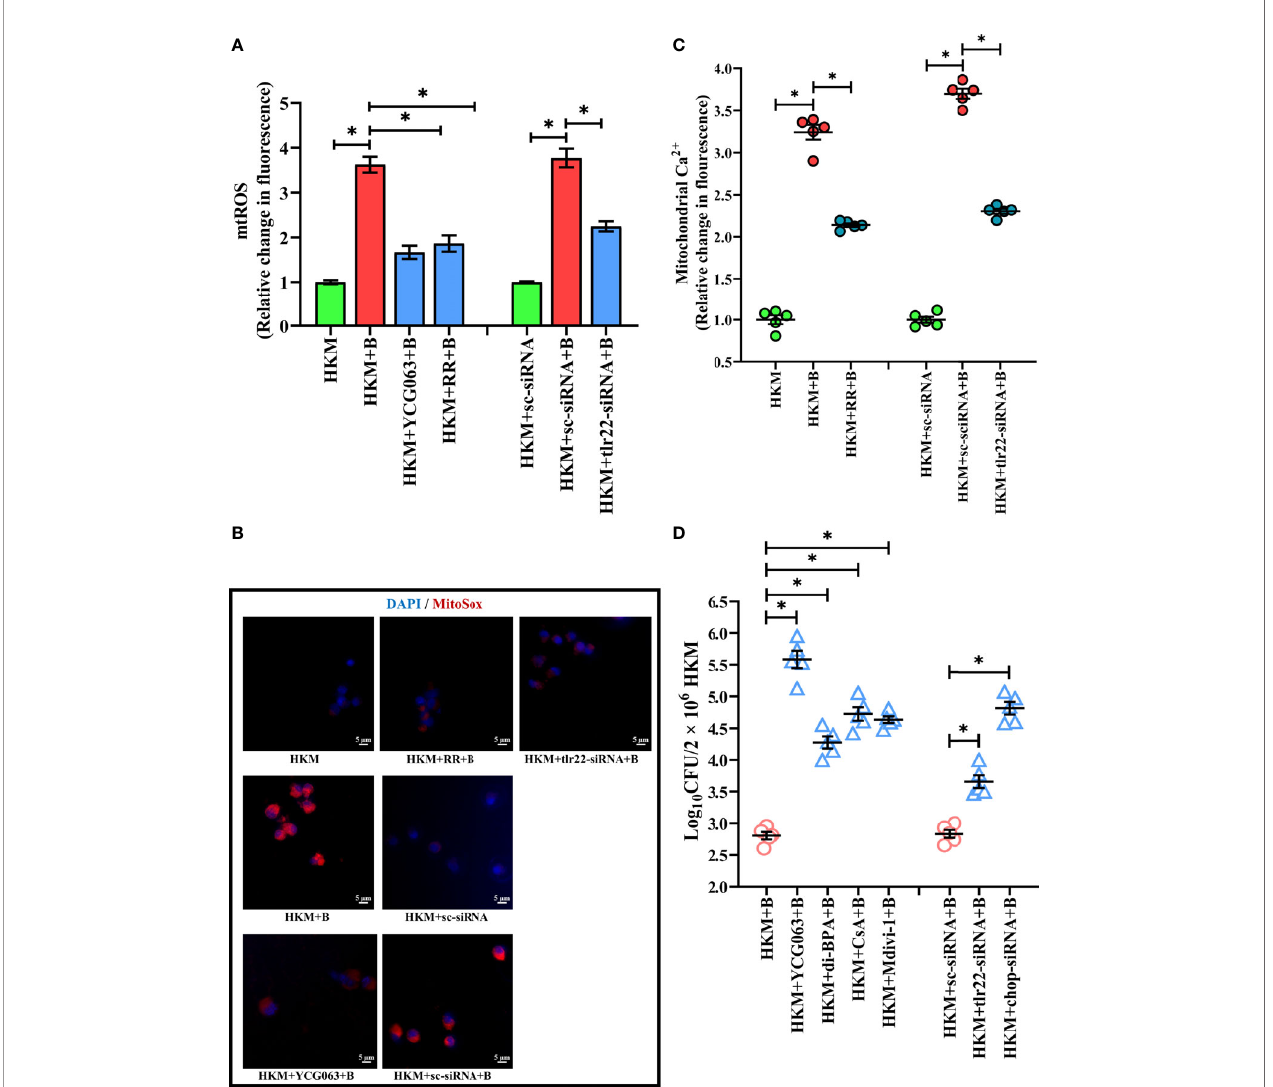
FIGURE 2 | TLR22-induced (Ca 2+ ) mt fl ux instigates pro-apoptotic mtROS generation in A. hydrophila -infected HKM. HKM pre-incubated with YCG063, RR or transfected with sc-siRNA, tlr22-siRNA were infected with A. hydrophila and at 4 h p.i. (A) changes in mtROS levels were measured, and (B) changes in mtROS levels were visualized under fl uorescence microscope. Vertical bars denote mean ± SEM (n=5). Fluorescence microscopic data is representative of three independent experiments. (C) HKM pre- incubated with RR or transfected with sc-siRNA, tlr22-siRNA were infected with A. hydrophila , and changes in (Ca 2+ ) mt were measured using Rhod-2/AM at 1 h p.i. (D) HKM pre-incubated with YCG063, di-BPA, CsA, Mdivi-1 or transfected with sc-siRNA, tlr22-siRNA were infected with A. hydrophila and bacterial load were enumerated at 24 h p.i. Data represent mean ± SEM (n=5). Asterisk (*) signi fi es signi fi cant difference between the indicated group (* p < 0.05). HKM, uninfected HKM; HKM+B, HKM infected with